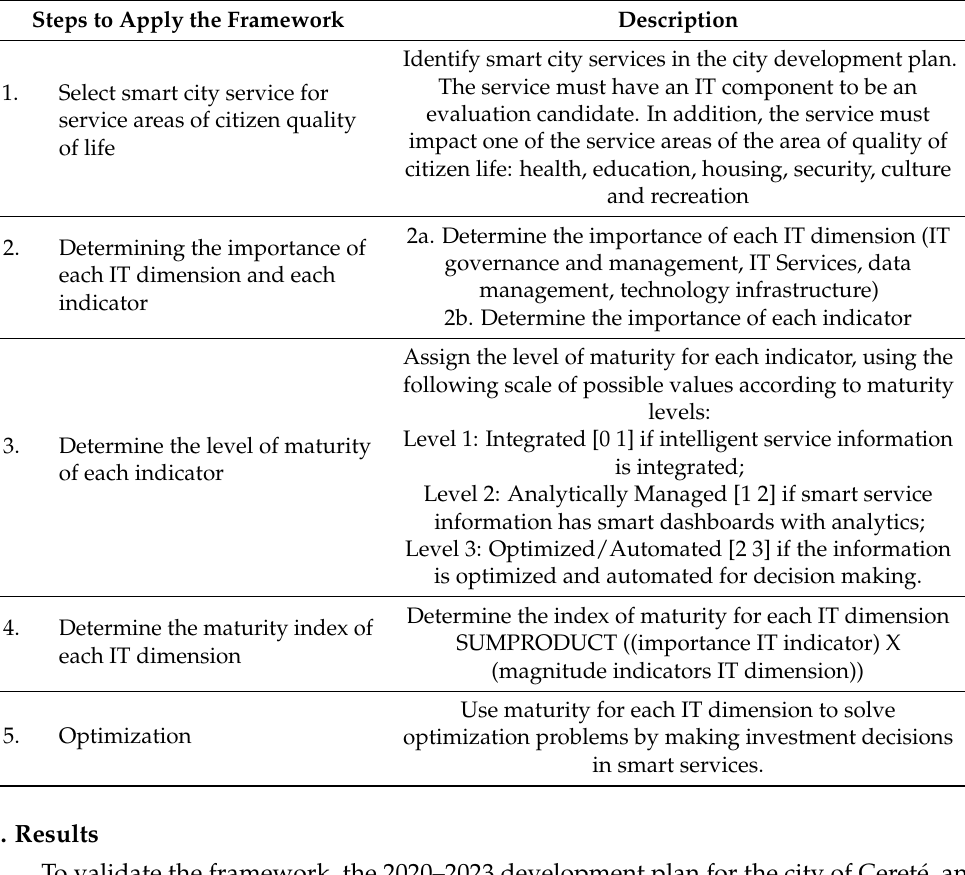
Table 6. Application steps framework